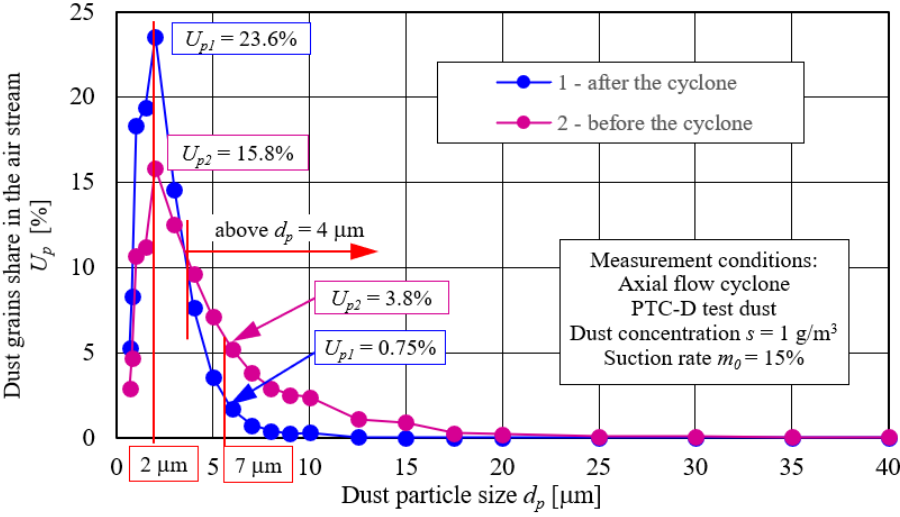
Figure 6. Particle size distribution of PTC ‐ D dust in the air stream before (2) and after the cyclone (1).